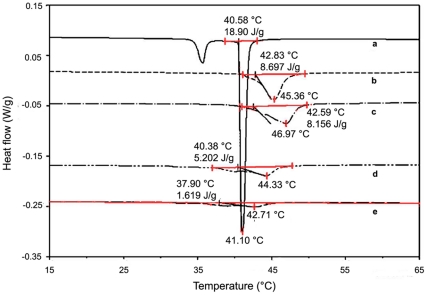
DSC analysis of pure and latanoprost loaded DPPC MLVs.The liposome was made by PBS buffer hydration of anhydrous drug-lipid layer. 10 µl of the liposomal formulation (100 mg/ml) was heated at 1°C/min between −20°C to 65°C. Three heating and two cooling cycles were carried out with each sample and the last reproducible heating cycle was considered for analysis. The drug/lipid mole ratios and their corresponding enthalpy change during transition are reported within parentheses (a) 0.0 (18.9 J/g), (b) 0.03 (8.7 J/g), (c) 0.086 (8.1 J/g), (d) 0.114 (5.2 J/g) and (e) 0.14 (1.6 J/g).